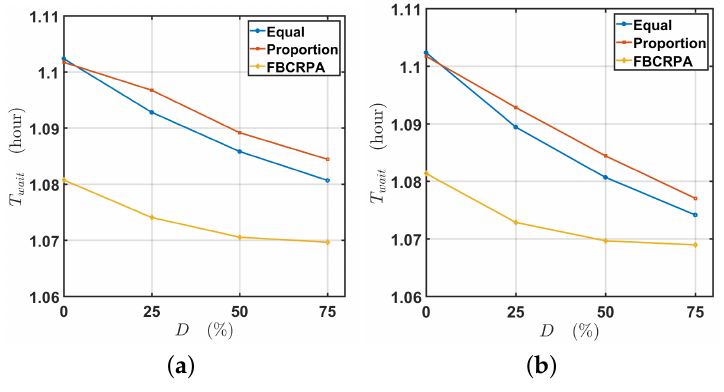
Figure 3. T wait of three schemes. ( a ) M = 0.5. ( b ) M =